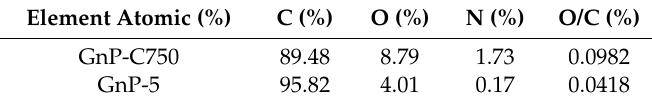
Figure 4. XPS spectra of ( a ) GnP-C750 and ( b ) GnP-5; C1s peak of ( c ) GnP-C750 and ( d ) GnP-5. Table 1. Atomic concentration of GnPs collected from XPS results